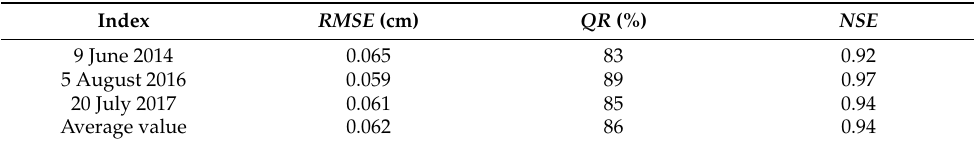
Table 3. The value of the evaluation indexes.